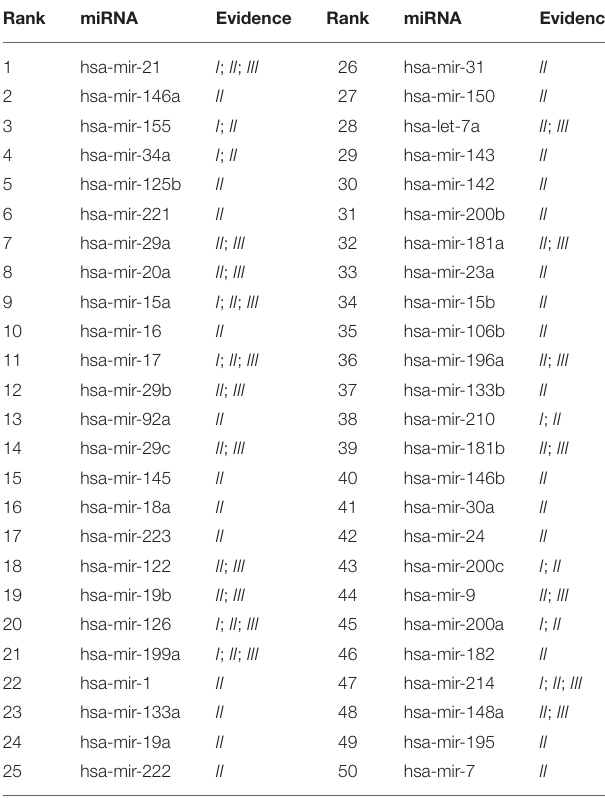
TABLE 5 | Top 50 predicted miRNAs related to Lung Neoplasms based on HMDD v2.0. Rank miRNA Evidence Rank miRNA